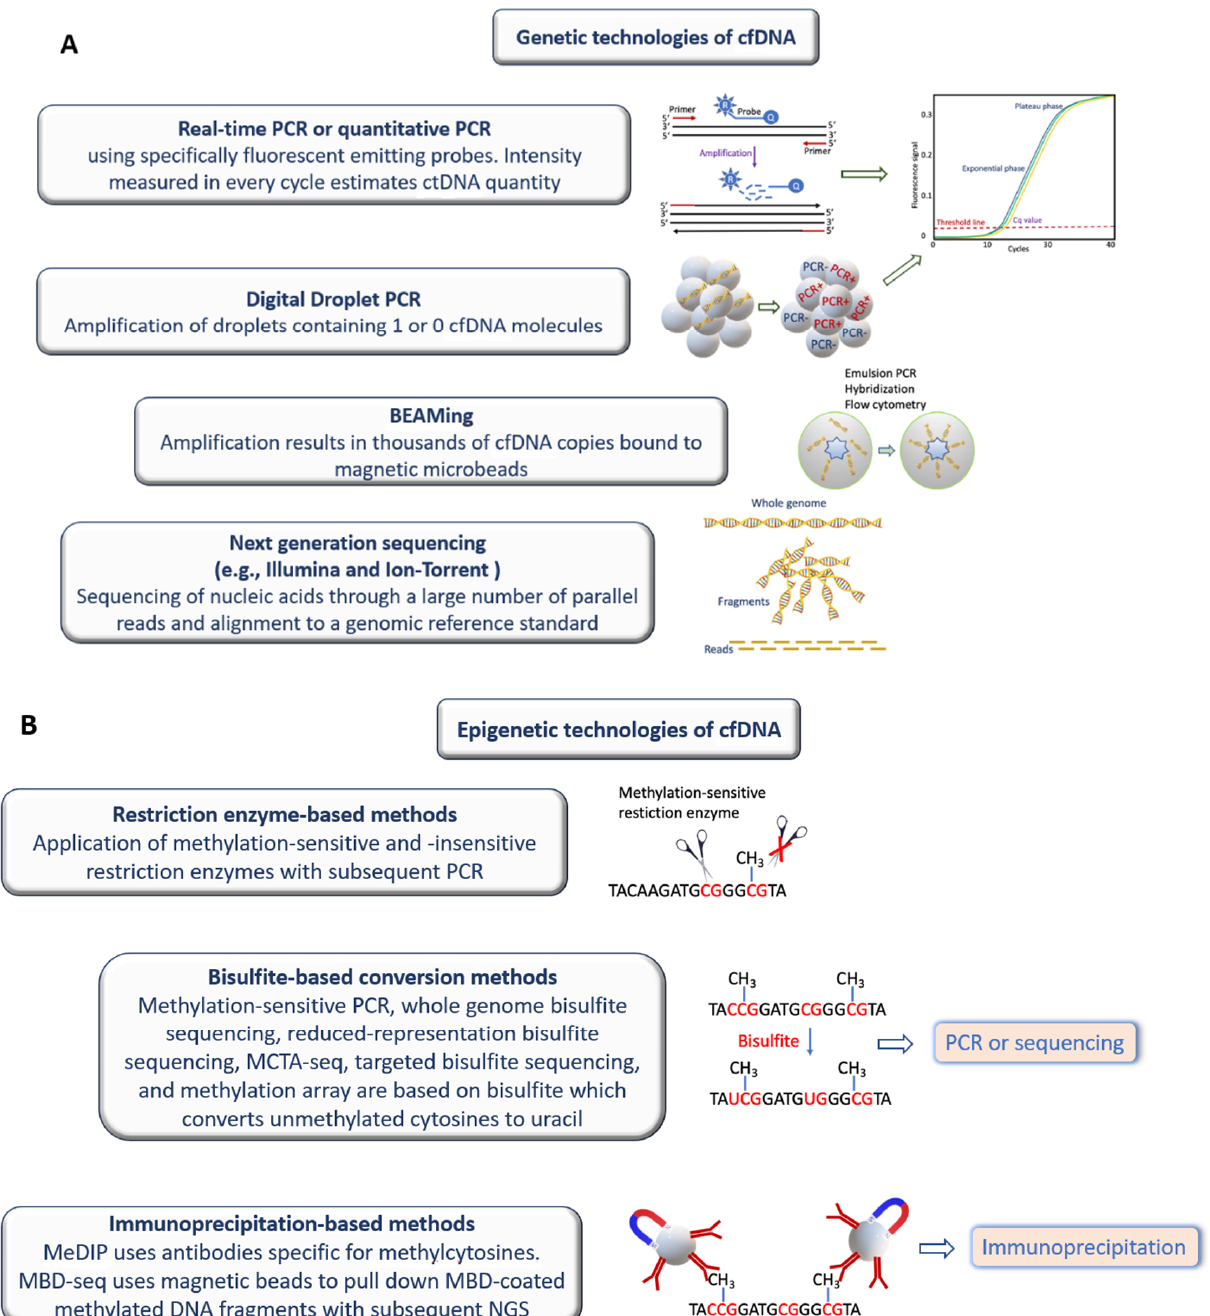
Figure 1. Genetic and epigenetic technologies of DNA. A descriptive summary and pictorial depiction of genetic ( A ) and epigenetic ( B ) technologies of DNA is shown. These diverse techniques were described in detail by Volik et al. [60].